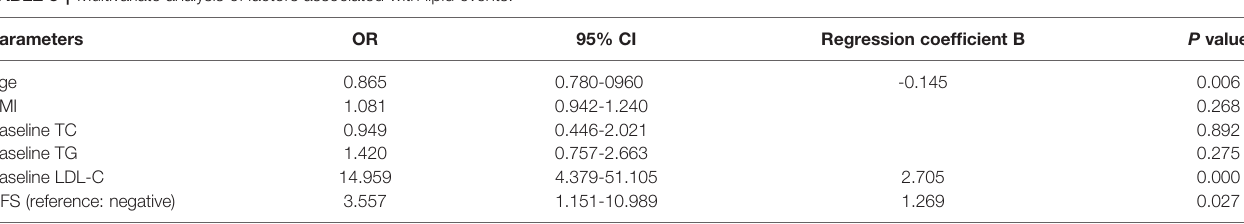
TABLE 3 | Multivariate analysis of factors associated with lipid